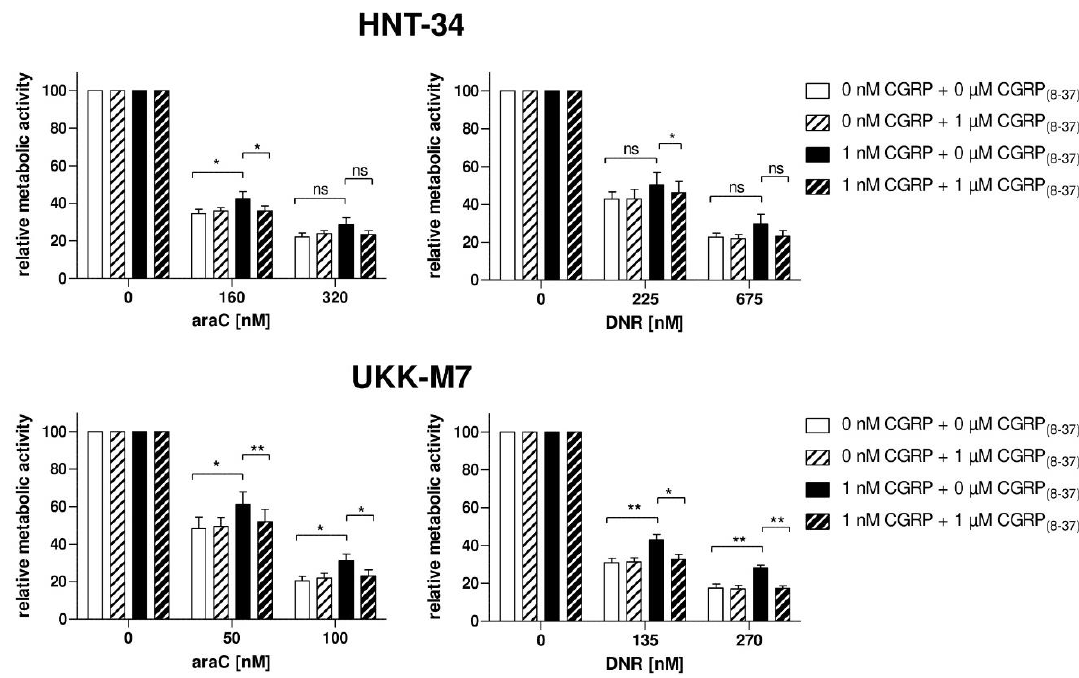
Figure 4. CGRP (8–37) counteracts the CGRP-induced increase in chemotherapy resistance. HNT-34 and UKK-M7 cells were pre-incubated first with or without 1 µM CGRP (8–37) for 15 minutes, next with or without 1 nM CGRP for 1 h, prior to addition of the indicated concentrations of araC or daunorubicin (DNR). CellTiter-Glo metabolic activity assay; means + SEM from 3 biological replicates. ns, not significant, * p < 0.05, ** p < 0.01, paired Student's two-tailed t-test.